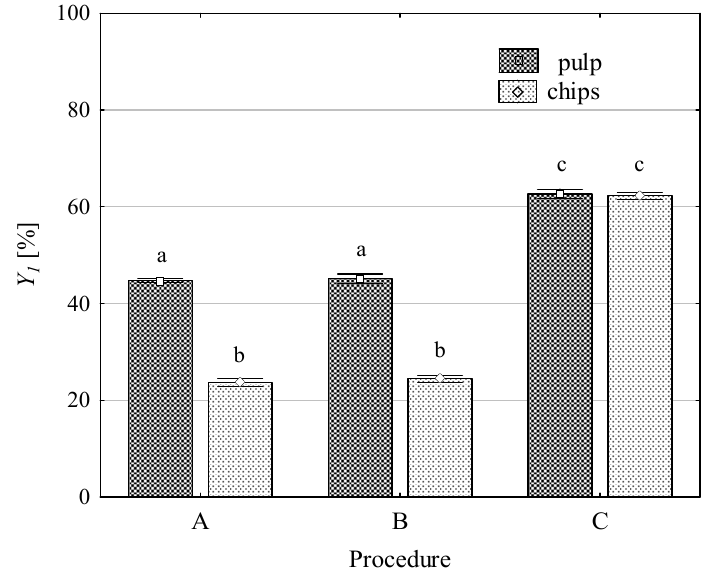
Figure 4. Impact of applied procedures on yield Y 1 in the first pressing cycle of ground celeriac root. Abbreviations, as in Figure 3. a, b, and c—average values marked with the same letter show no statistically significant difference ( p ≤ 0.05).